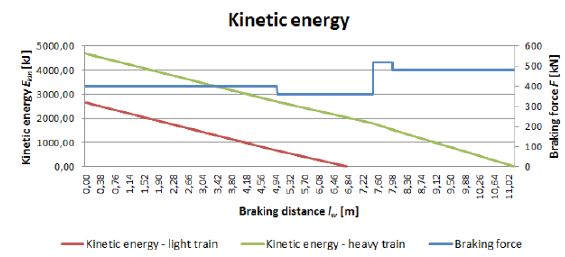
Figure 3. Kinetic energy and braking force along the braking distance (Example 1).